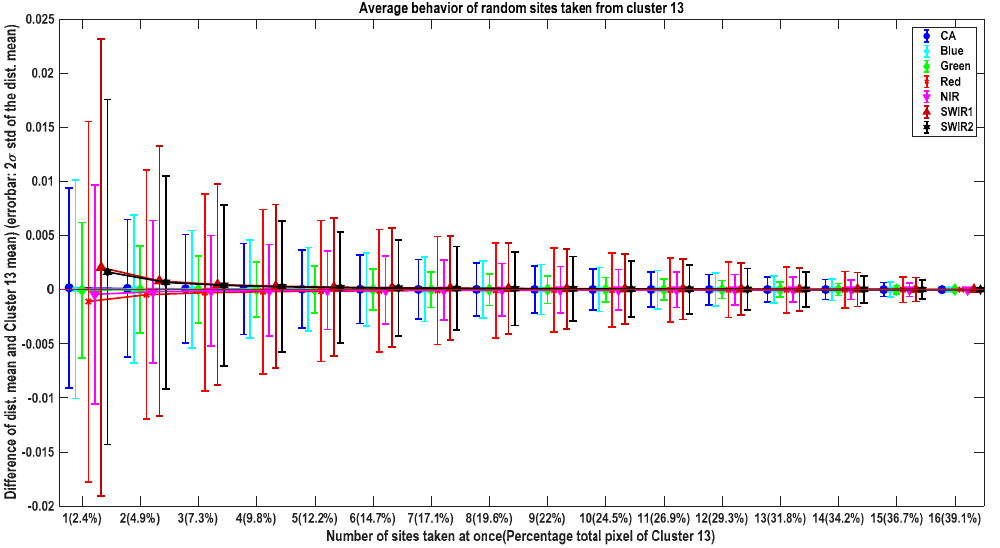
Figure 9. Average expected behavior of randomly selected site from Cluster 13. The error-bars represent the estimated standard deviation of the distribution means. As might be expected, using more distinct sites to represent the entire Cluster 13 region tends to decrease the uncertainty in the estimated reflectance mean. The envelope created by each band’s standard